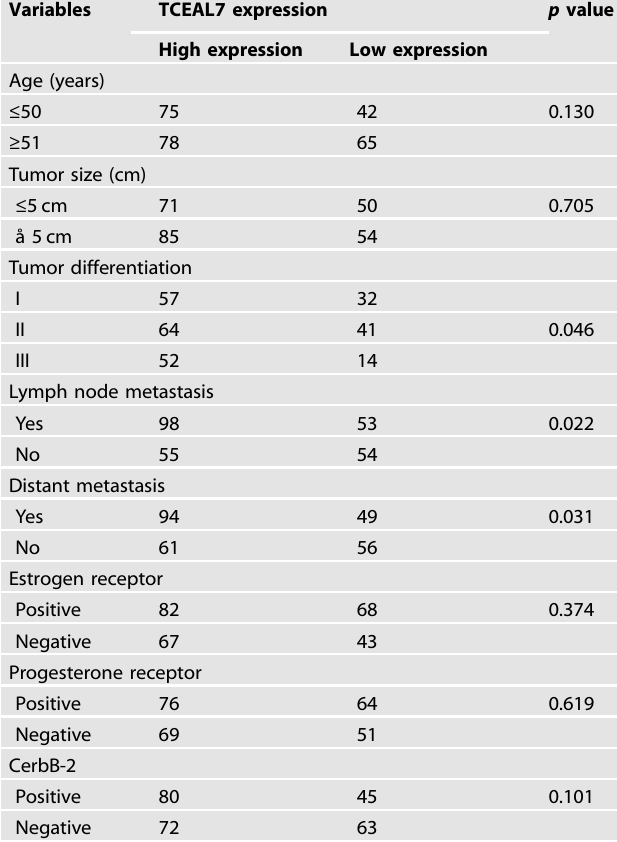
Table 1. Association between TCEAL7 expression and clinical features of breast cancer